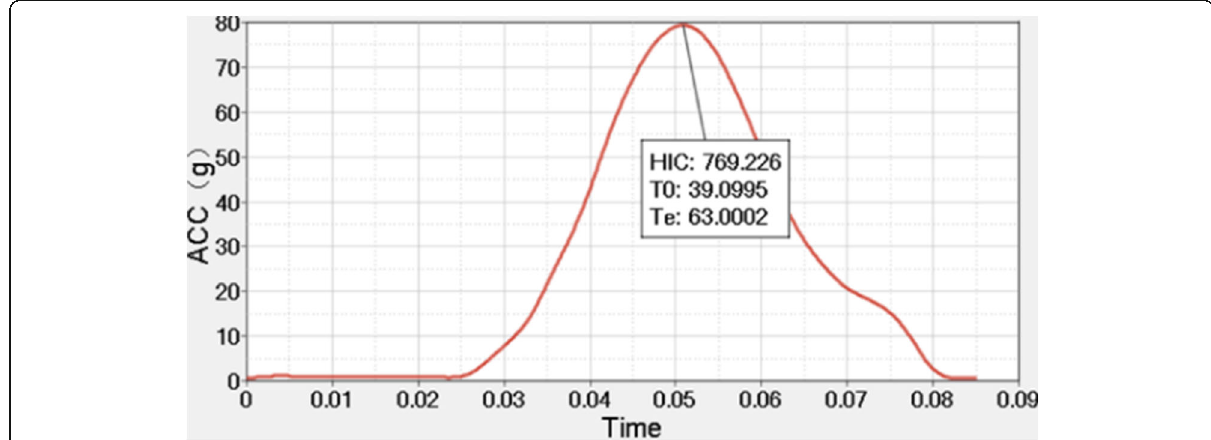
Fig. 19 The result of head injury value with the airbag protection at the opening angle of